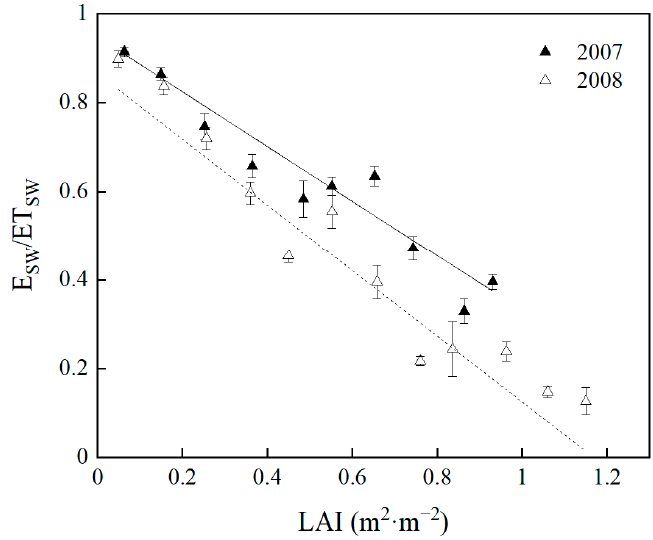
Figure 7. Relationships between leaf area index ( LAI ) and the ratio of soil evaporation to evapotranspiration estimated by the S–W model ( E SW / ET SW ) for 2007 and 2008. The E SW / ET SW data for 2007 and 2008 were averaged with LAI bins of 0.1 m 2 · m − 2 . Bars indicated ± 1 standard error. The solid line represents the fitted regression for the data of 2007, the dash line represents the fitted regression for the data of 2008. For 2007: E SW / ET SW = − 0.62 × LAI + 0.95, R 2 = 0.96, p < 0.001; for 2008: E SW / ET SW = − 0.59 × LAI + 0.89, R 2 = 0.96, p < 0.001.